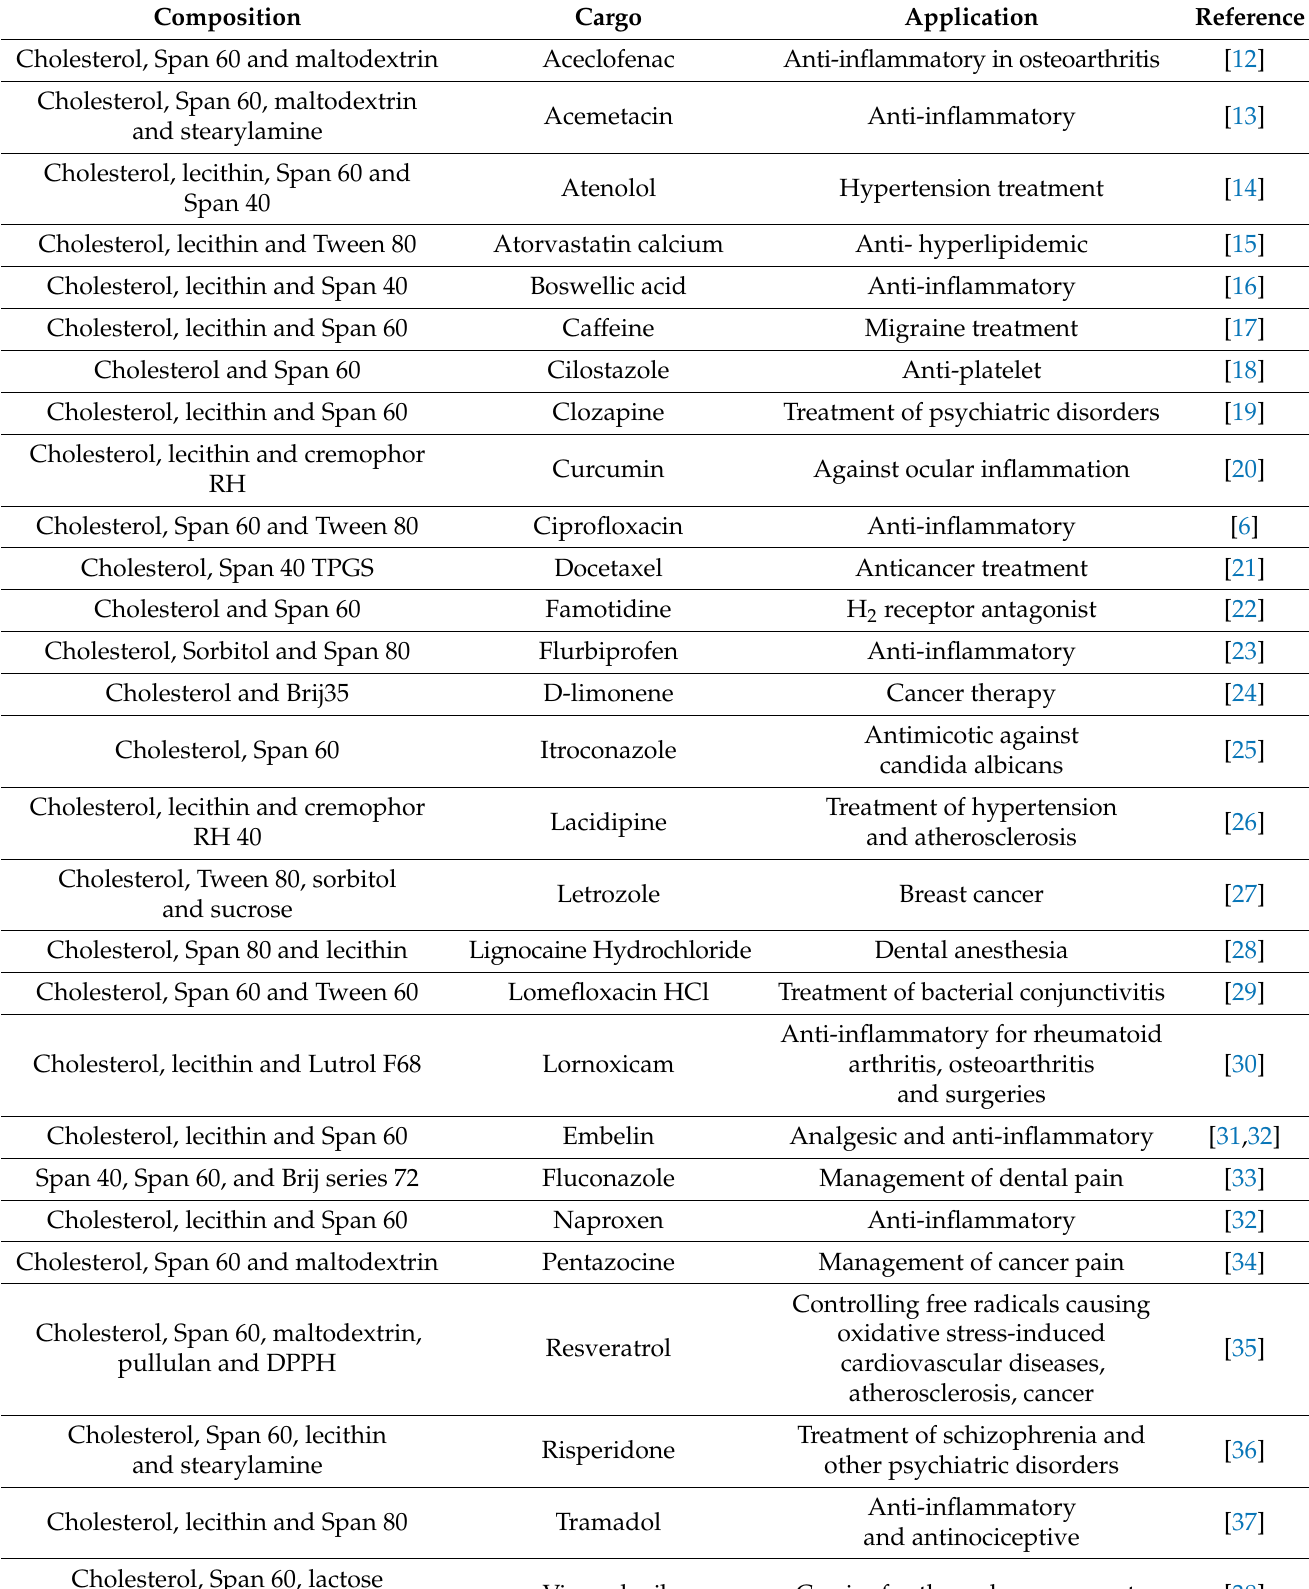
Table 1. Proniosomes’ drug delivery